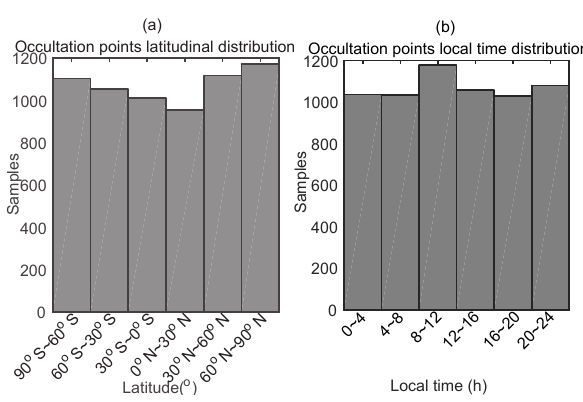
Figure 2. Fengyun-3C occultation point distribution with the lati- tude (a) and local time (b) .